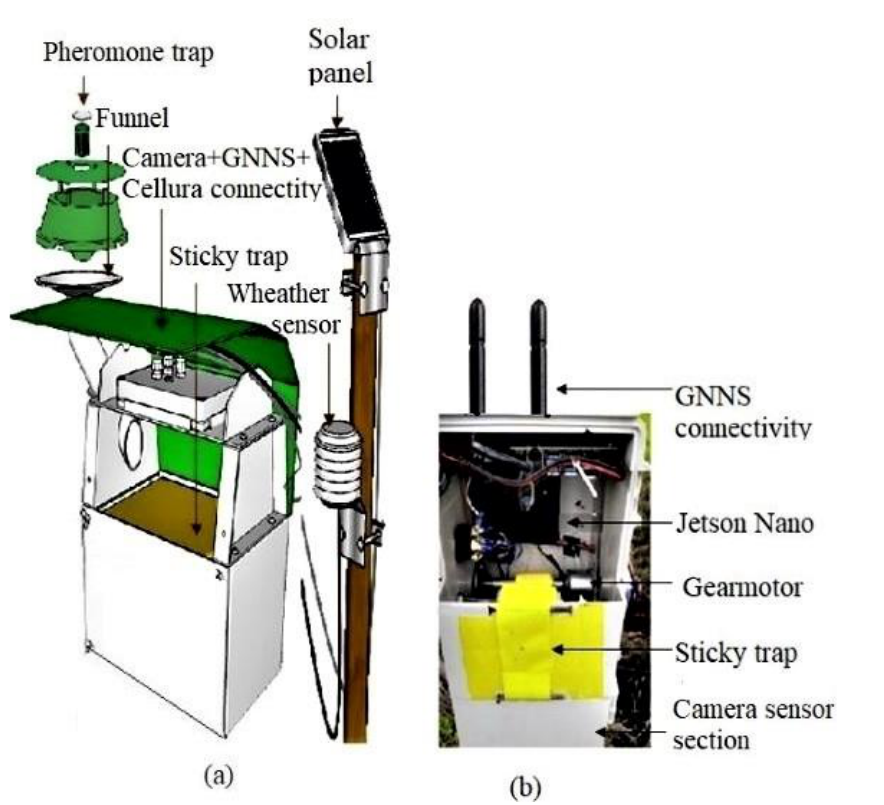
Figure 3. Remote monitoring devices for cotton pest identification. ( a ) Self-cleaning trap [45], also shown at https://app.efos.si/trapview_help/html/Trapview_SCM.html (accessed on 22 November 2022). Permission granted, and ( b ) Remote whitefly monitor [32].